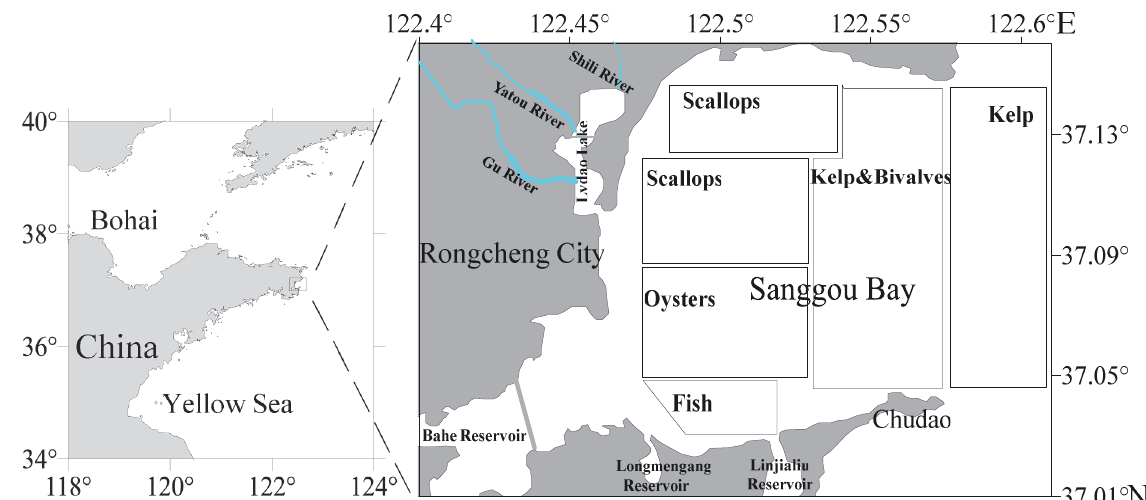
Fig. 1. Location of Sanggou Bay, China, and the main aquaculture